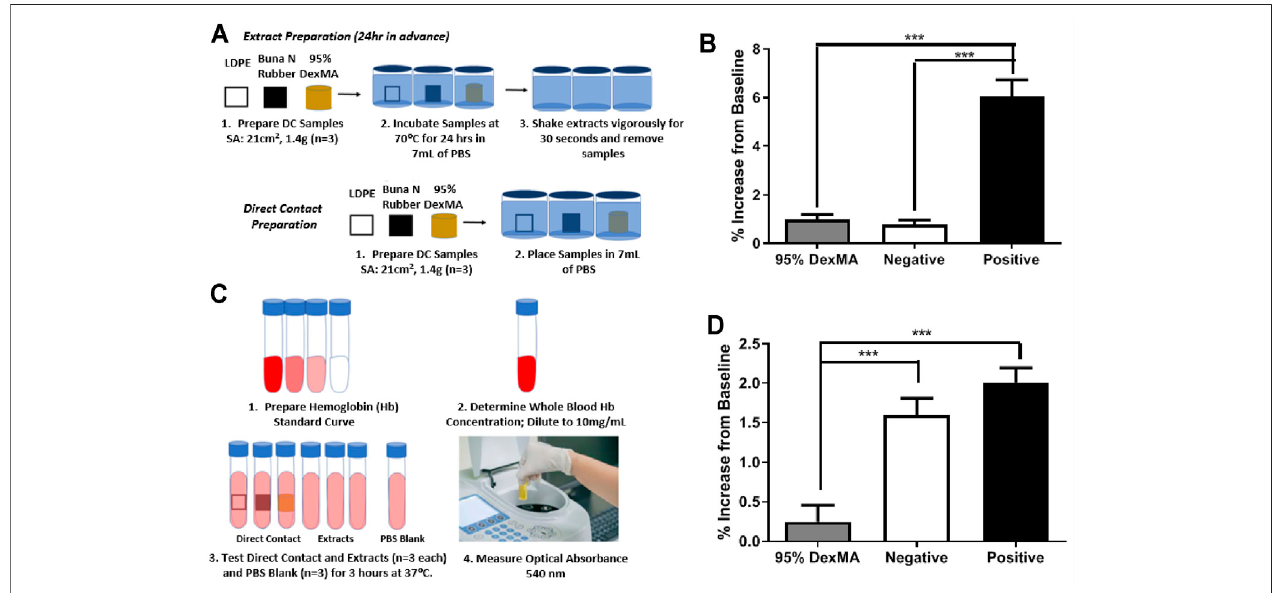
FIGURE 7 | (A) Schematic of sample preparation for hemolytic tests. (B) Percent hemolysis of sample extracts, background subtracted relative to PBS ( n (cid:1) 3; mean ± s.d.;*** p < 0.001). (C) Schematicofhemolysistestingprocedure. (D) Percenthemolysisofdirectcontactsamples,backgroundsubtractedrelativetoPBS( n (cid:1) 3; mean ± s.d.; *** p <